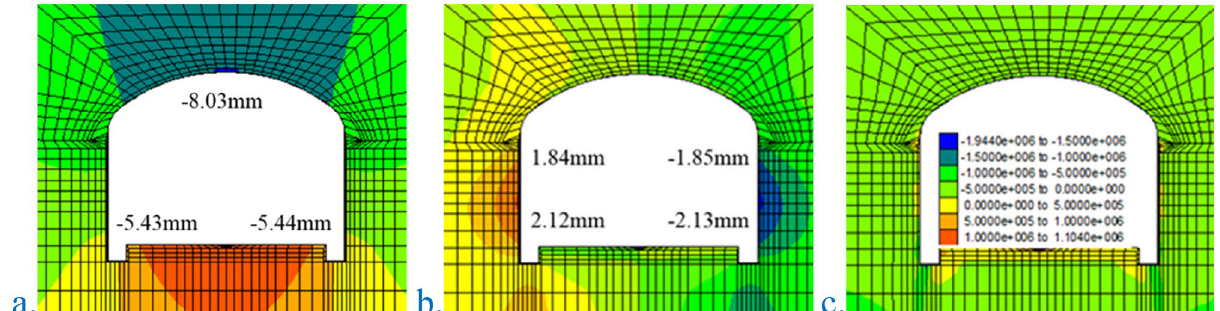
Figure 18. Simulation results of the level-IV2 surrounding rock. ( a ) Vertical displacement; ( b ) horizontal displacement; ( c ) small principal stress.